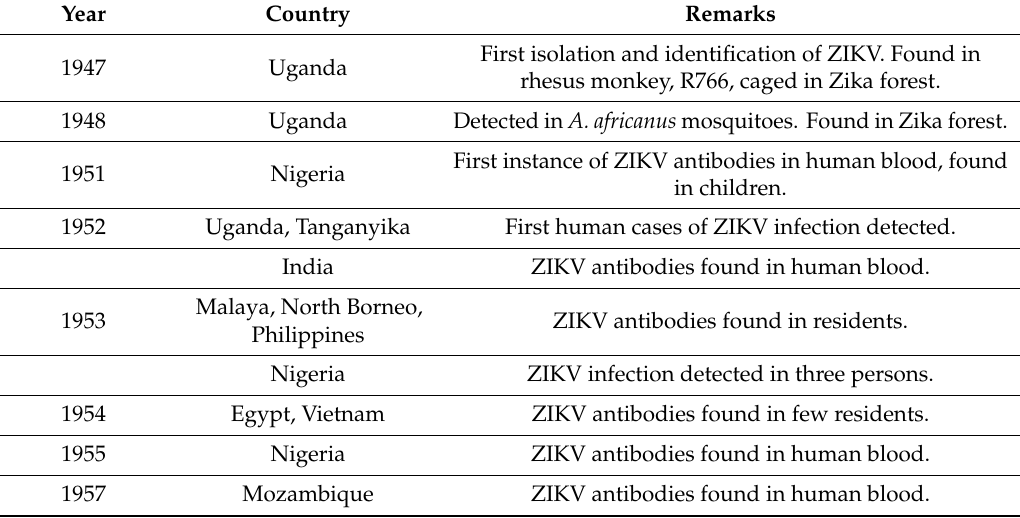
Table 2. The pre-epidemics period of the Zika virus after its detection in 1947. A. africanus : Aedes africanus ; ZIKV: Zika virus.